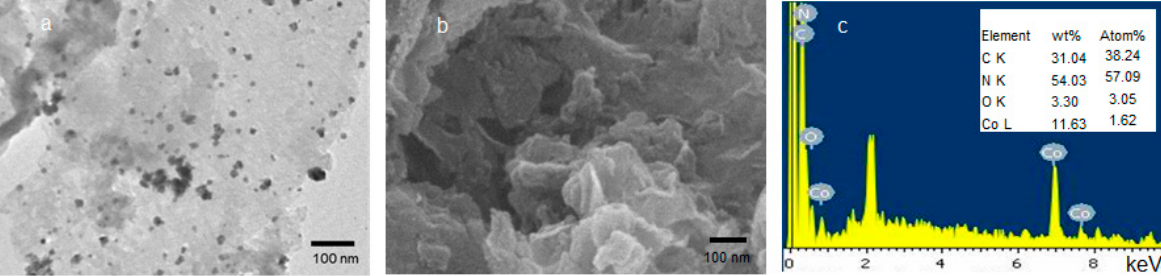
Figure 3. ( a ) A TEM image, ( b ) a FE-SEM image, and ( c ) EDS analysis with an inset table of the element content of Co(11)@g-CN.